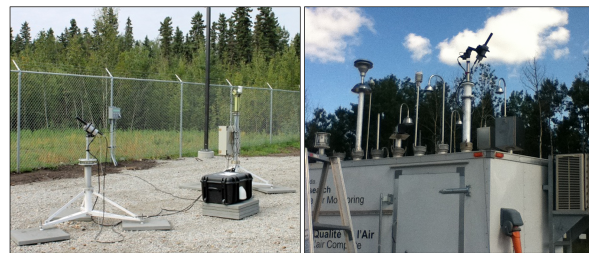
Figure 1. Pandora instruments at Fort McKay in (left) 2013 and (right) 2014–2015. In 2013, the instrument’s optical head was in- stalled on a white Brewer tripod and the spectrometer and computer were inside the black box to the right. From 2014, the head was in- stalled on the roof of a trailer with the spectrometer and computer located inside the